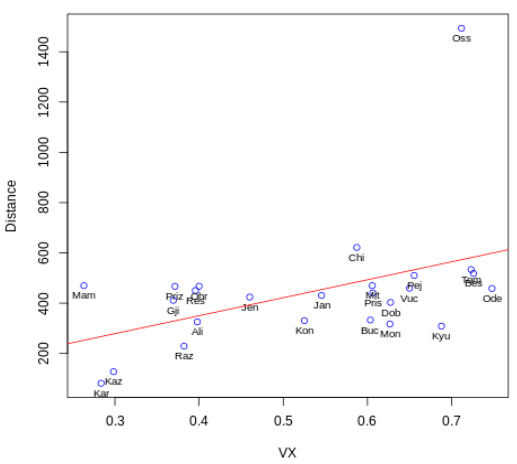
Figure 3. Correlation between distance from Kap ı kule and frequency of VX